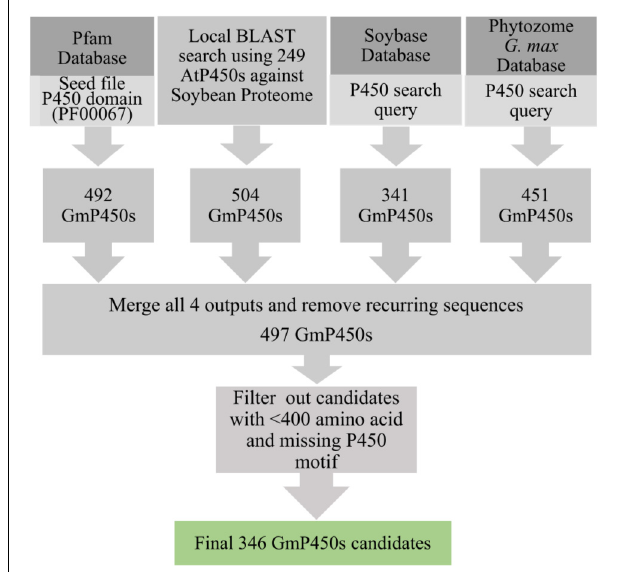
FIGURE 1 | Strategy used for the identification of GmP450s. A flow diagram showing the number of hits obtained from each database search and filtering criteria that resulted into a final list of 346 putative GmP450s in